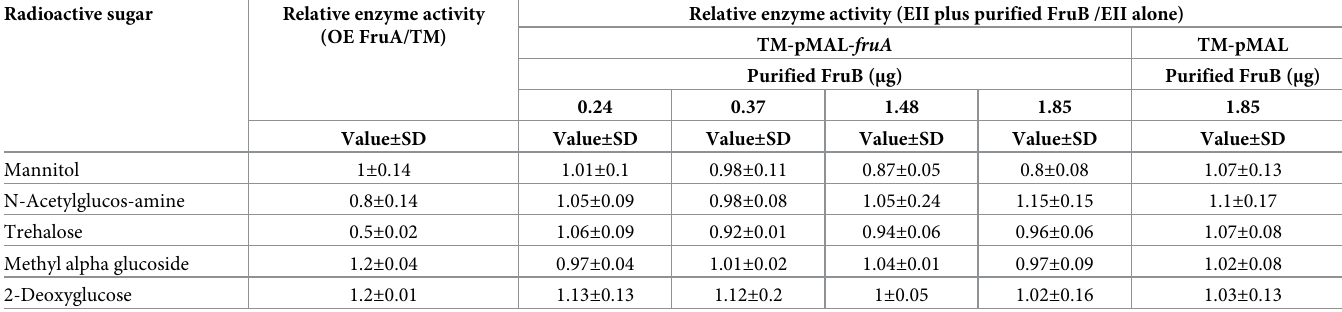
Table 4. Effects of overexpressing fruA and varying amounts of purified FruB on the transphosphorylation activities of tested enzyme II complexes. Results are expressed as the ratios of enzyme activities in the presence relative to the absence of purified FruB for the different preparations. The raw data are presented in S25 and S26 Tables. In all cases, neither FruA nor FruB influenced the transphosphorylation activities for the 5 sugar-specific Enzyme II complexes assayed. Radioactive